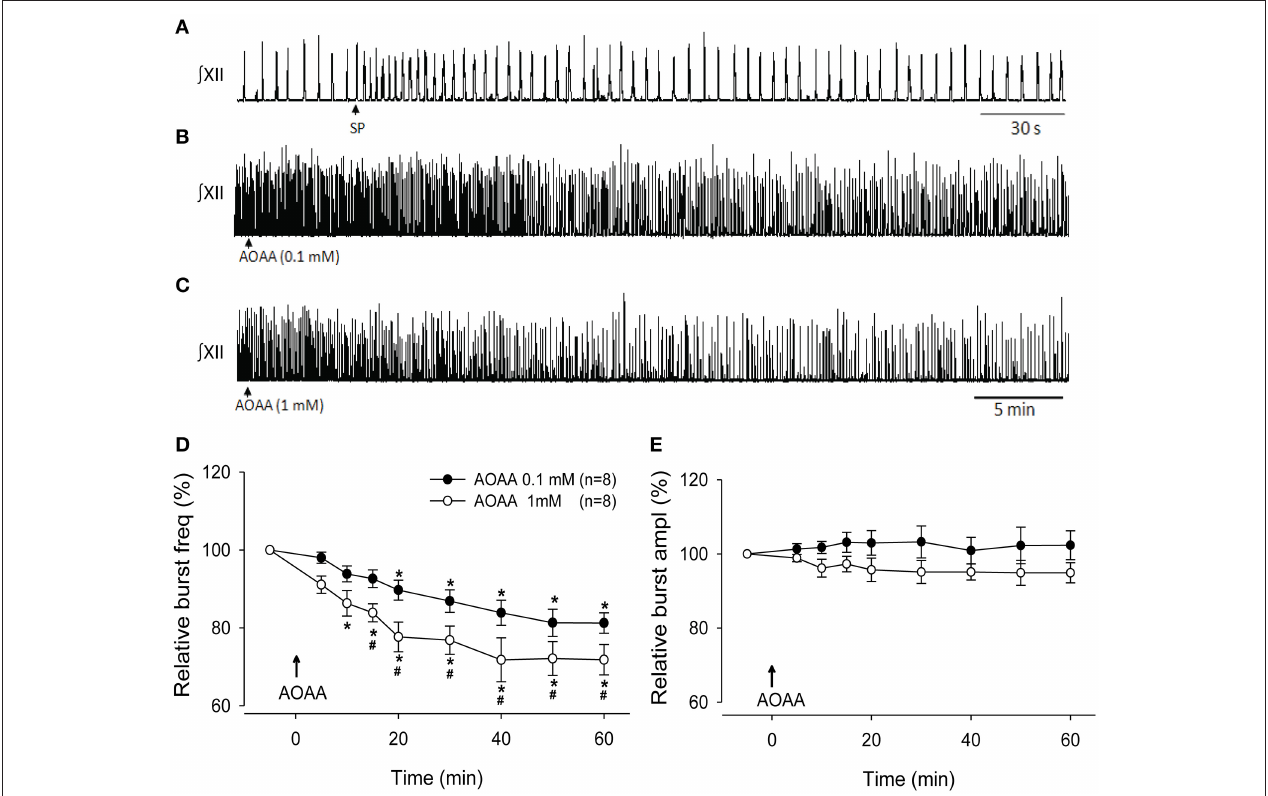
FIGURE 3 | Effect of local injection of AOAA into the preBötC on activity of the rhythmic medullary slice. (A) XII nerve recording depicting the rapid, > 2-fold, SP-evoked (1 µ M, 10s) frequency increase that is used to functionally identify the preBötC. Arrow indicates the time of SP injection. (B,C) XII nerve recording showing the effects on inspiratory-related activity of locally injecting AOAA (0.1mM, 30s), (B) 1mM, 30s, (C) into the PreBötC. Arrows indicate the time of AOAA injection; time scale is the same in (B) and (C) . (D,E) Group data ( n = 8) showing the time course of changes in burst frequency (D) and amplitude (E) evoked by local injection AOAA into the preBötC. Arrows indicate the time of injection; time scale is the same in (B) and (C) . *indicates time point when frequency first fell significantly below baseline; # indicates significant difference between values at 0.1 and 1.0mM AOAA ( p <